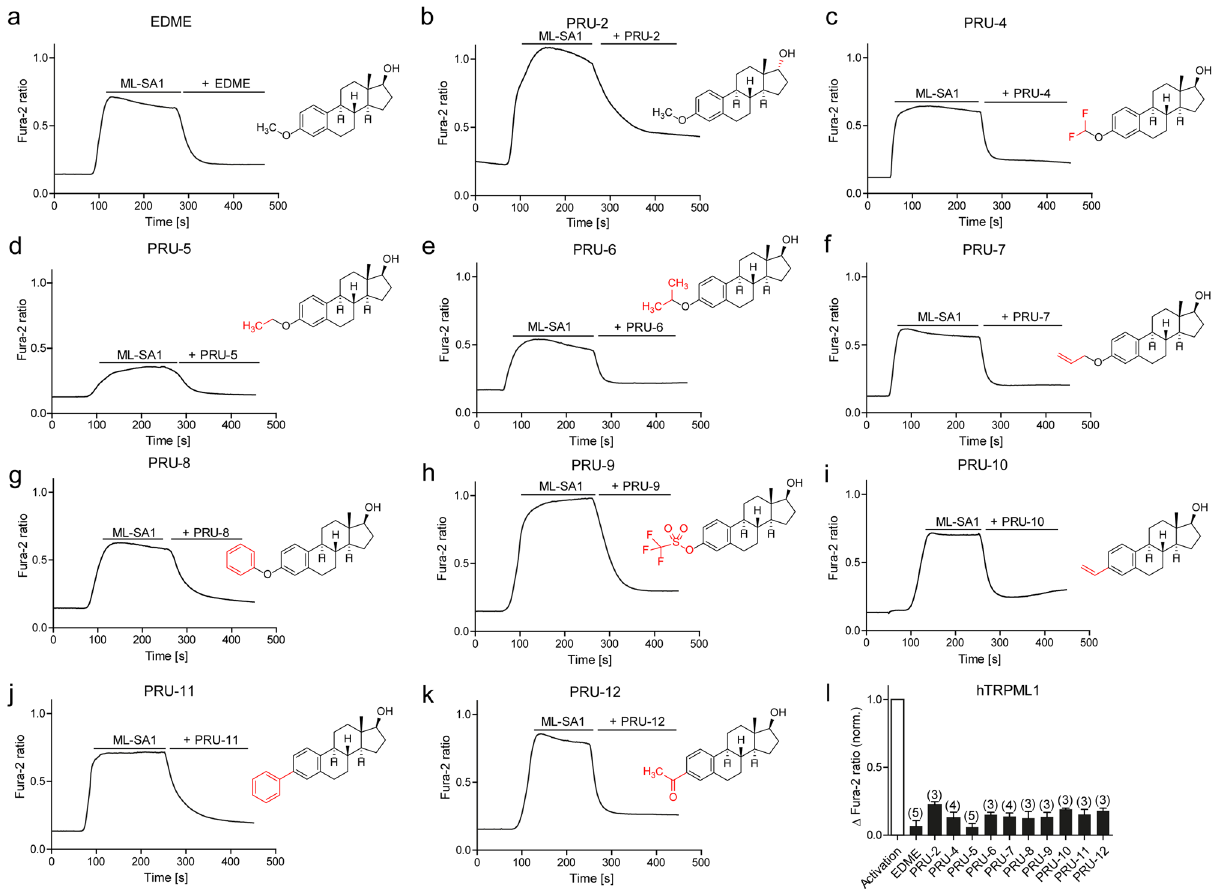
Figure 3. EDME and analogs in Fura-2 single cell calcium imaging experiments. ( a – k ) Representative Fura-2 calcium signals recorded from HEK293 cells stably expressing hTRPML1∆NC-YFP. Cells were stimulated with ML-SA1 (10 µM), then treated with EDME and analogs (10 µM, each). Characteristic structural motifs of the EDME analogs are highlighted in red in the structures. ( l ) Statistical analysis of the maximal change in Fura-2 ratio (mean ± SEM) with the number of independent experiments in parentheses (with 5–12 cells in each experiment). Data were normalized to the maximal effect of the agonist